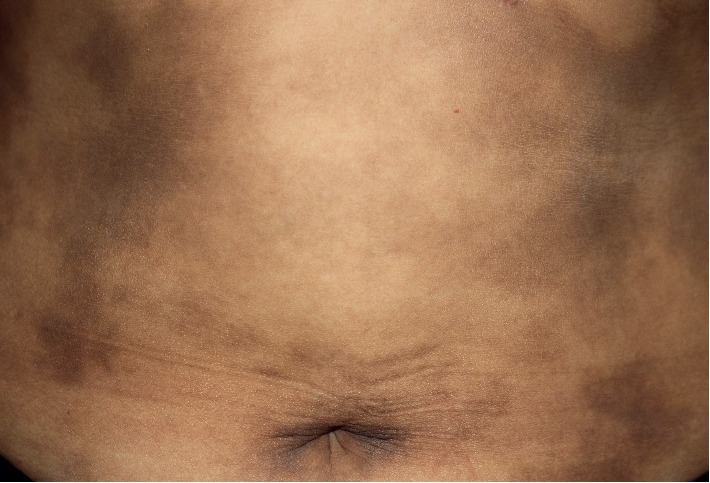
Typical characteristics of AD on clinical examination.